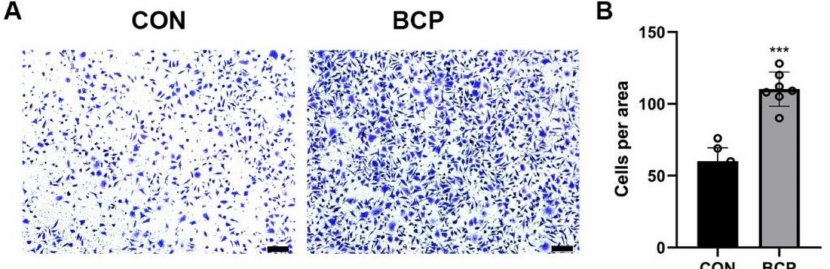
Figure 7. Migration ability of L929 fibroblasts induced by BCP ceramics. ( A ) Representative images of transwell assay and ( B ) Semi-quantitative results showed migration ability of L929 fibroblasts was elevated by BCP ceramics. Scale bar: 100 µ m. *** indicated p < 0.001.